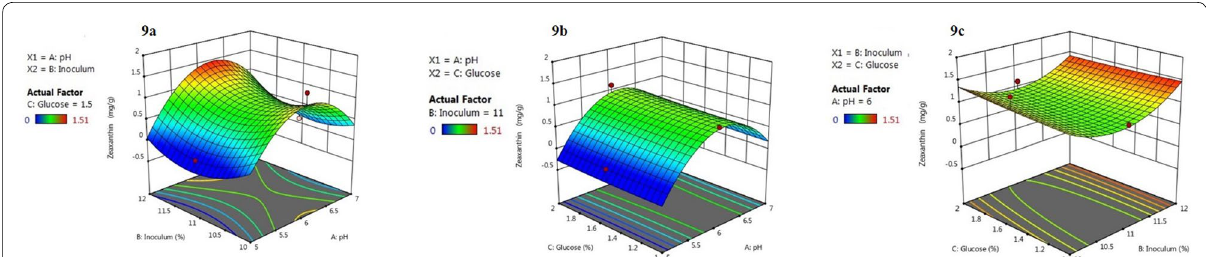
Fig. 9 a Response surface plot of zeaxanthin yield vs inoculum, pH. The regions of surface plot are divided in three regions depicting zeaxanthin yield in mg/g, glucose concentration, and inoculum size in percentages. b Yield vs glucose, inoculum, and c yield vs glucose,